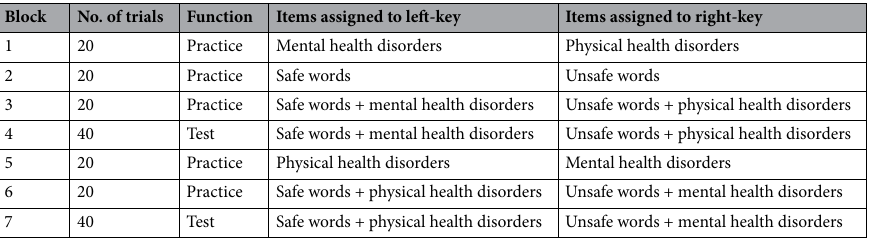
Table 1. Sequence of trial blocks for the mental health prejudice